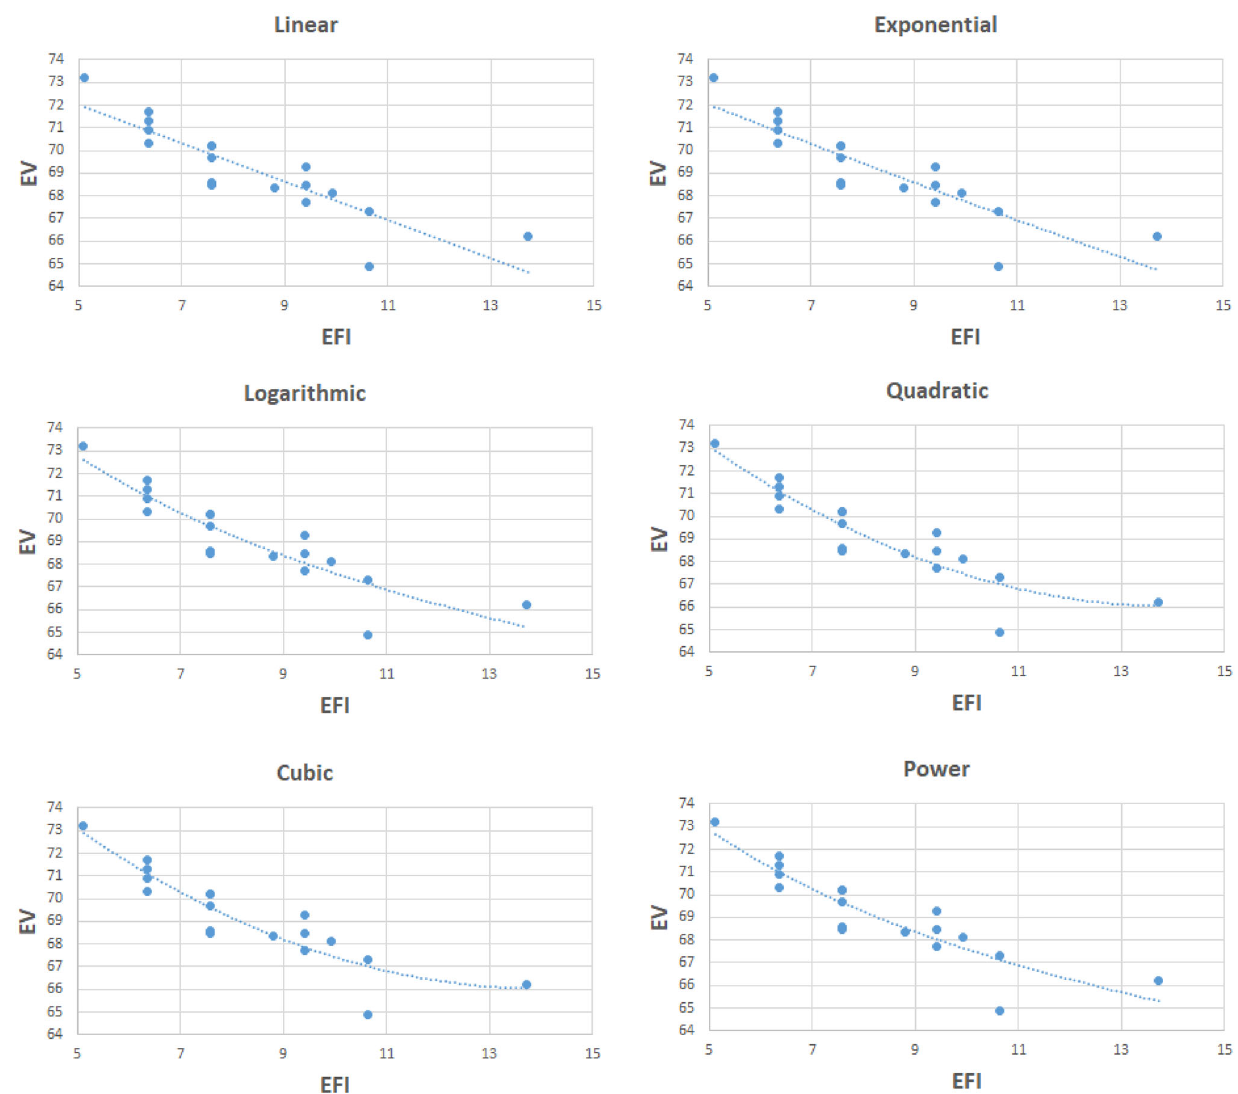
Fig. 3 The correlation of edge F-index with enthalpy of vaporization for octane